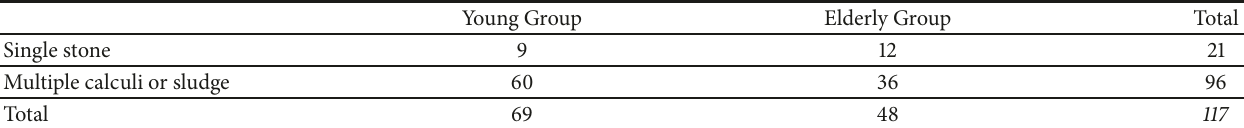
Table 3: Presence of gallbladder stones in patients who were admitted with the complaint of right upper quadrant pain. Young Group Elderly Group